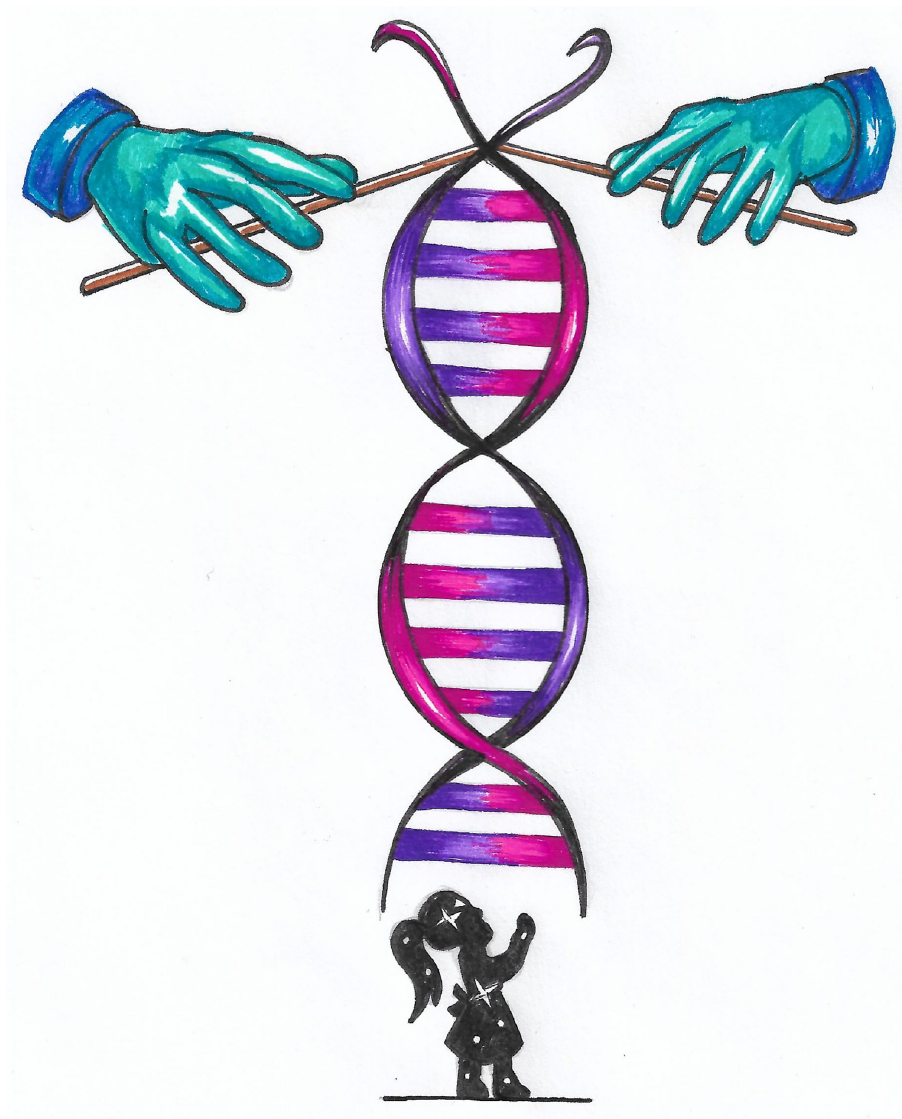
Fig 9. Encourage STEM education. Girl building her education in STEM (Illustrated by Jose Faustino